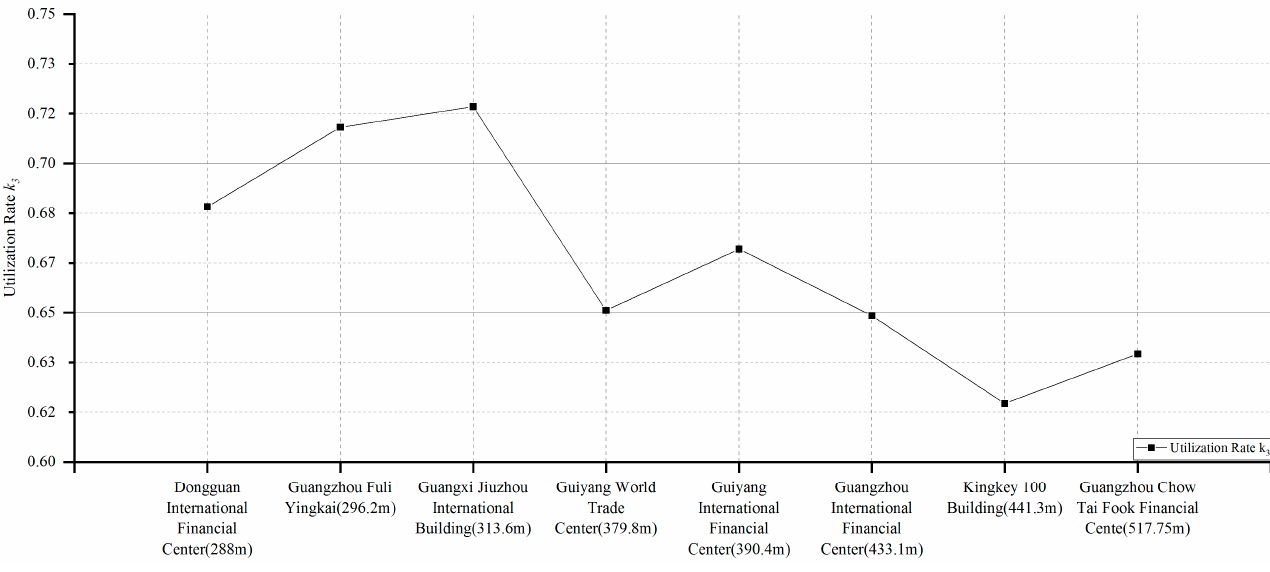
Figure 26. Building utilization rate k 3 .